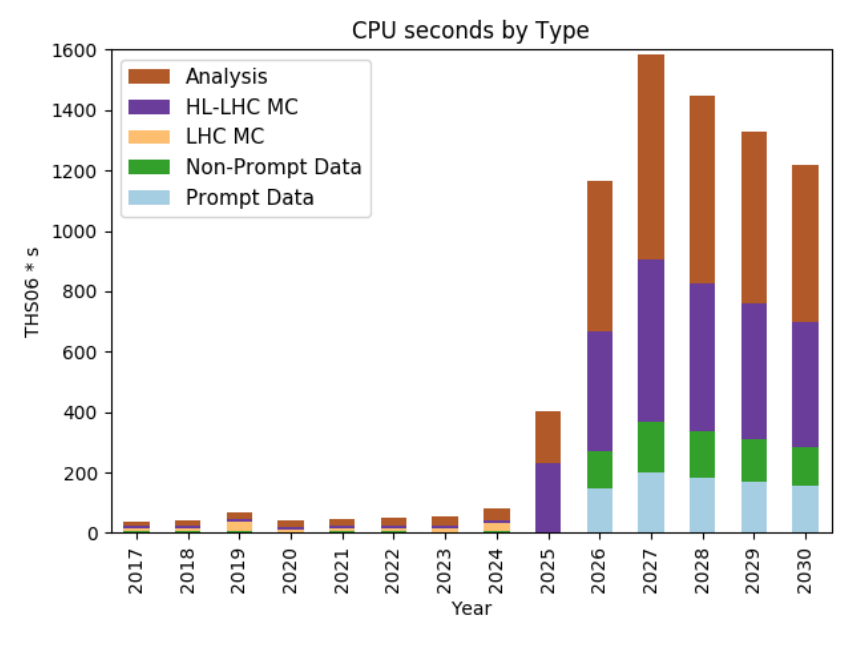
Figure 2. Extrapolating needed CPU for